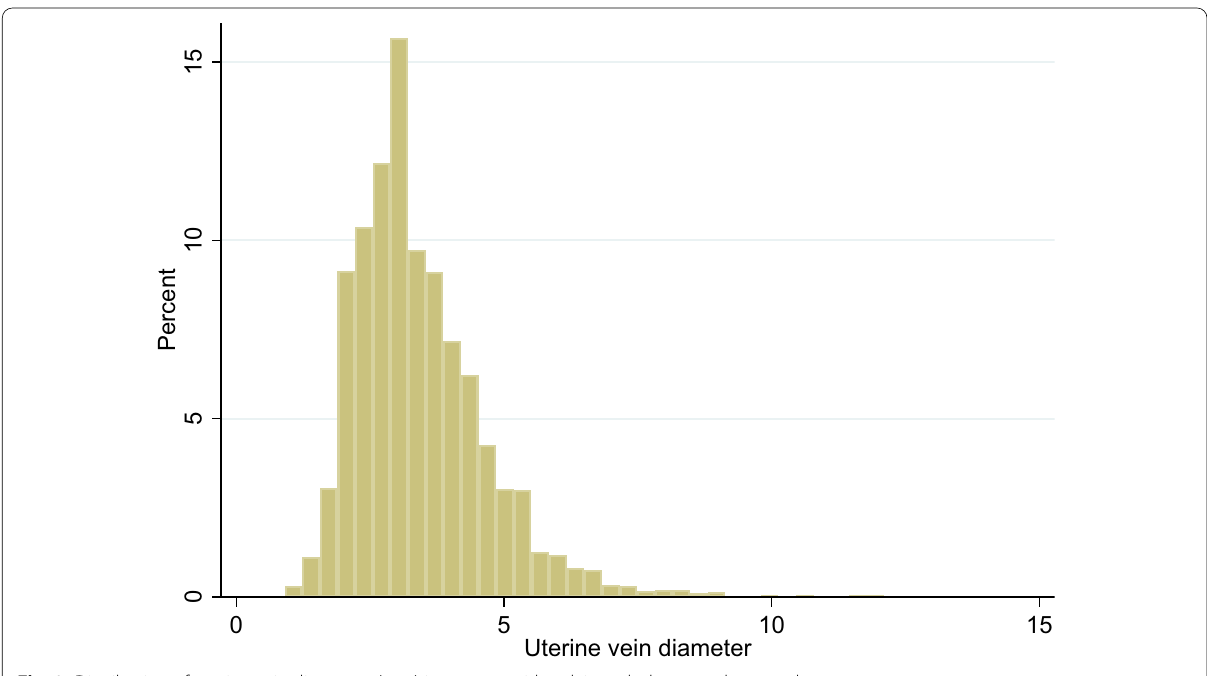
Fig. 2 Distribution of uterine vein diameters (mm) in women with pelvic pathology on ultrasound